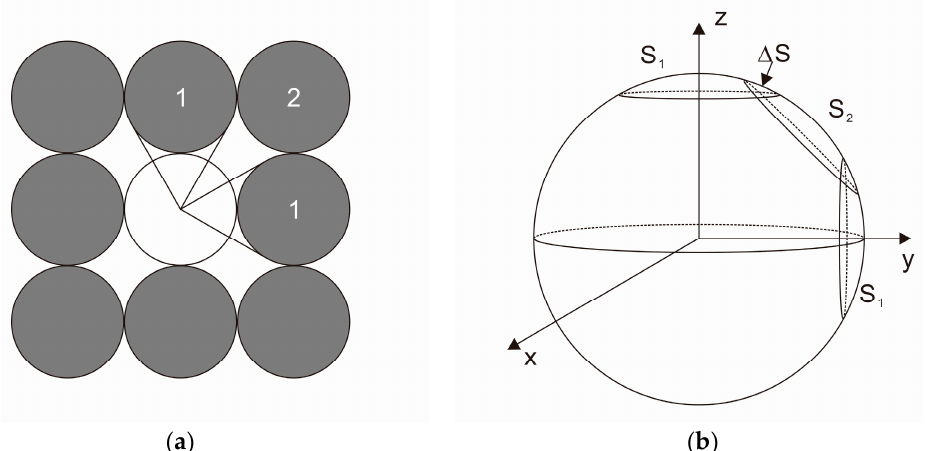
Figure A2. Schematic representation of receptors (grey circles) for the particle lateral scattering ratio x a . ( a ) 2-Dimension sketch of receptors (grey circles) and emitting particle (white circle); ( b ) projection areas for the numbered particles in ( a ), S 1 is the projection area for Particle 1, S 2 is the projection area for Particle 2, ∆ S is the overlapping area.